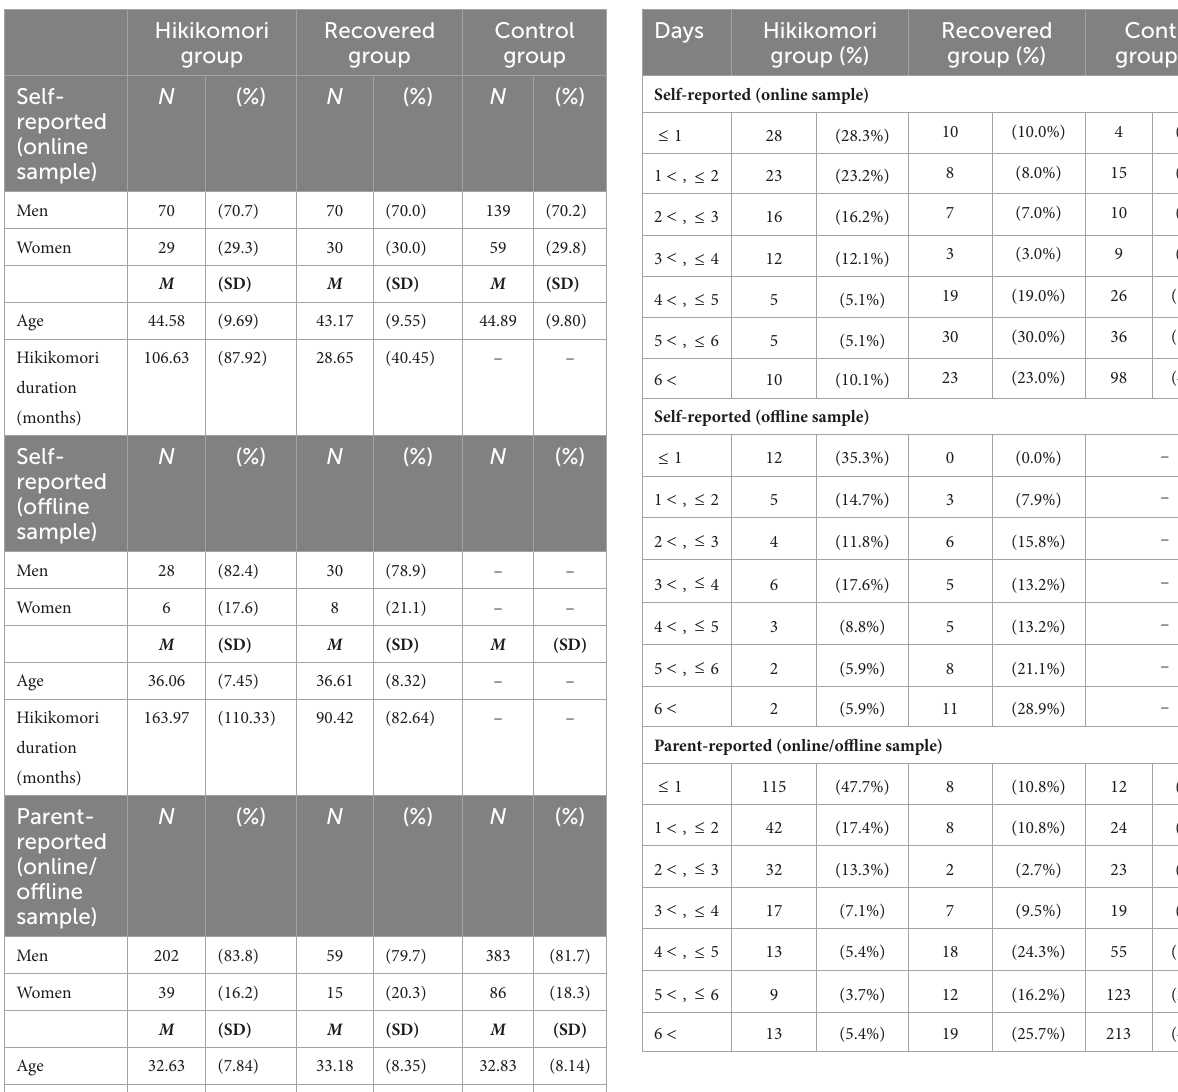
TABLE 1 Demographic characteristics of participants. TABLE 2 Outing frequency categories in each